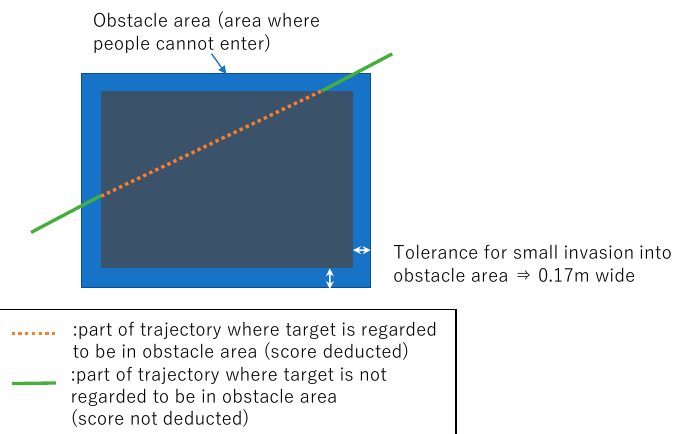
Figure 7. An evaluation metric for obstacle interference checks whether the points on the submitted trajectory enter the forbidden areas. This metric is evaluated at all of the points that comprise the trajectory. If the points lie in the obstacle area, the score is deducted. A 0.17-m wide tolerance area is defined for ignoring the small amount of invasion into the obstacle area.